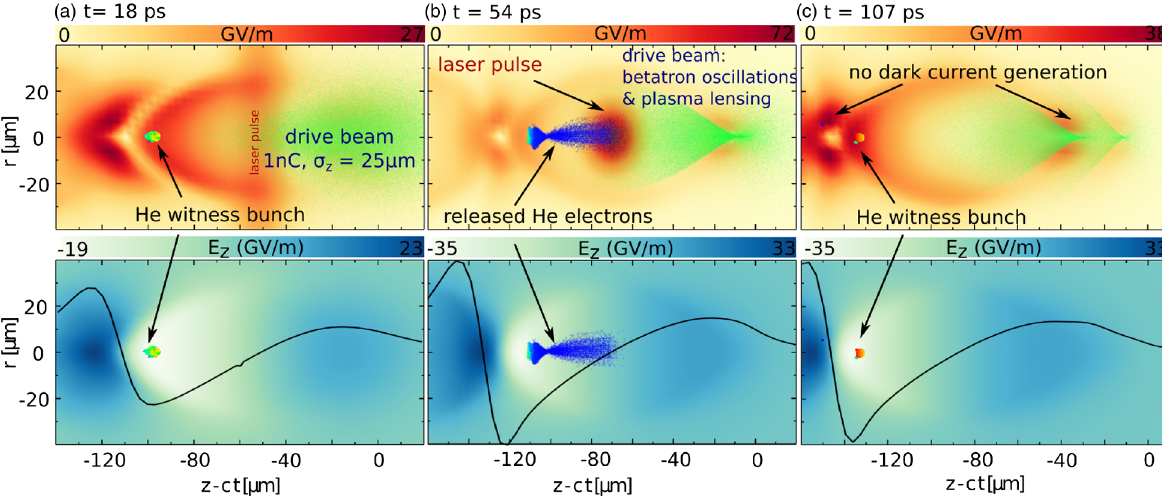
FIG. 4. Blowout and drive beam at different interaction times (i.e., the arrival of the injector laser) in a dark current free TH-PWFA scenario with relaxed requirements on pre-ionization ( n e ¼ 1 . 1 × 10 17 cm − 3 , λ p ¼ 100 μ m) and drive bunch density. In (a) t ¼ 18 ps ( z ¼ 5 mm), the TH injector laser releases electrons at the beginning of the interaction, while at (b) t ¼ 54 ps ( z ¼ 16 mm) and (c) t ¼ 107 ps ( z ¼ 32 mm), the release position is located later, where plasma lensing and betatron oscillations have distorted the drive bunch shape and local charge density, leading to increased trapping but at the same time avoids dark current generation. The top snapshots show the sum of the electric field, while the bottom snapshots show the longitudinal field, where the on-axis lineout of the field is shown in black solid